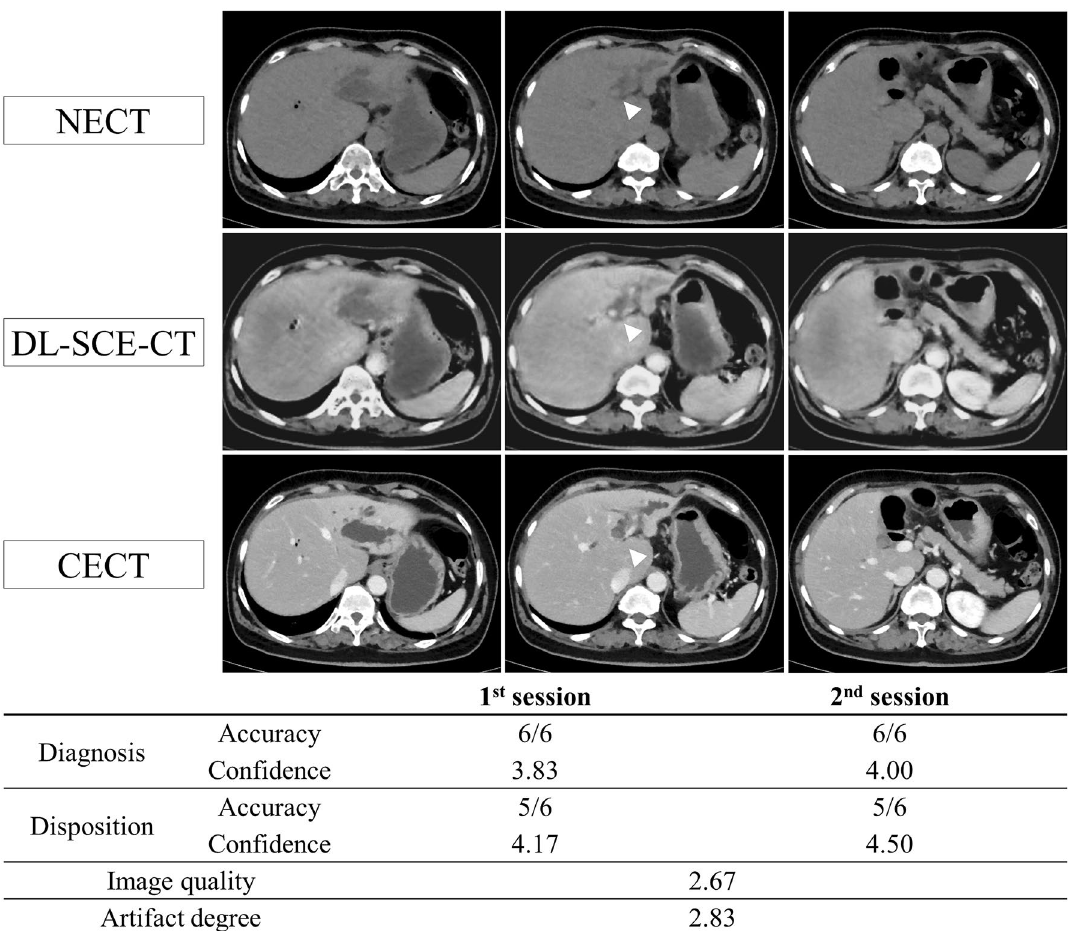
Figure 3. A 65-year-old female patient who visited the ED complaining of abdominal pain and fever. CT images show intrahepatic duct stones (arrowhead) with dilated upstream bile ducts. The contrast among the liver parenchyma, fluid within the dilated bile duct, and stones within the bile duct are more evident in DL-SCE-CT than in NECT. The patient was admitted for management of obstructive cholangiohepatitis. In this case, 100.0% (6/6) and 83.3% (5/6) of radiologists made the correct diagnoses and disposition decisions (intrahepatic duct stones with biliary obstruction, admission for medical management), regardless